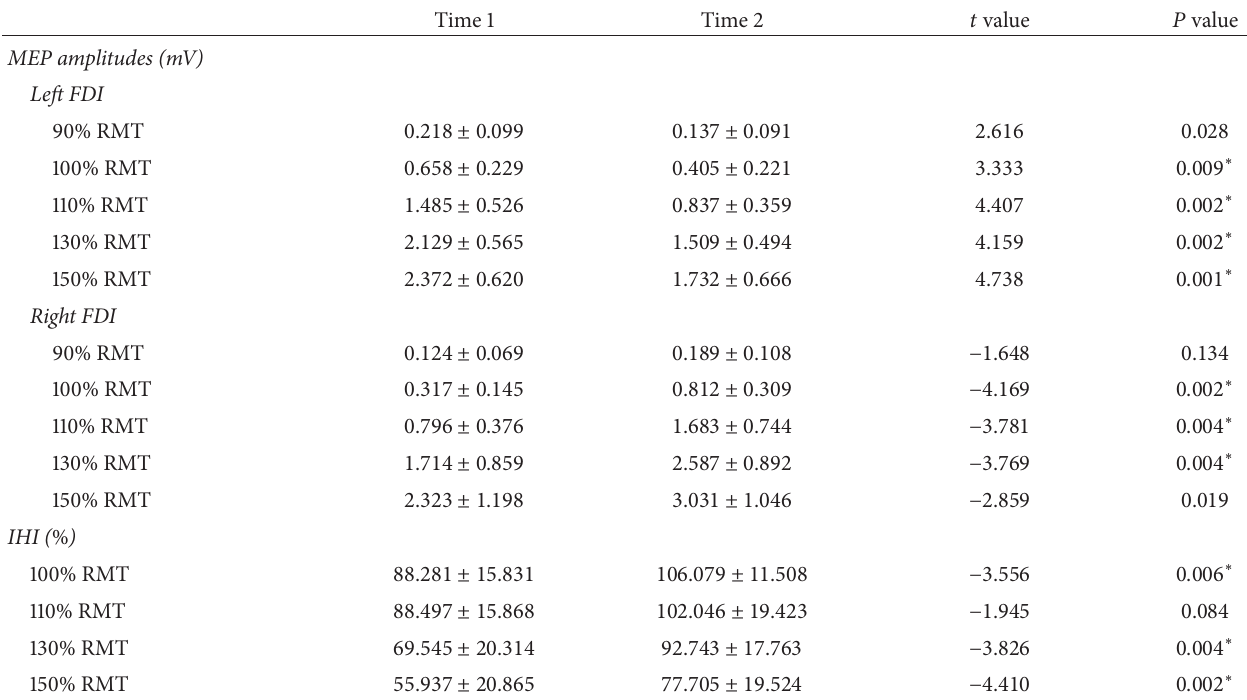
Table 2: Post hoc comparison by paired 𝑡 -test on MEP amplitudes and IHI before and after acupuncture.